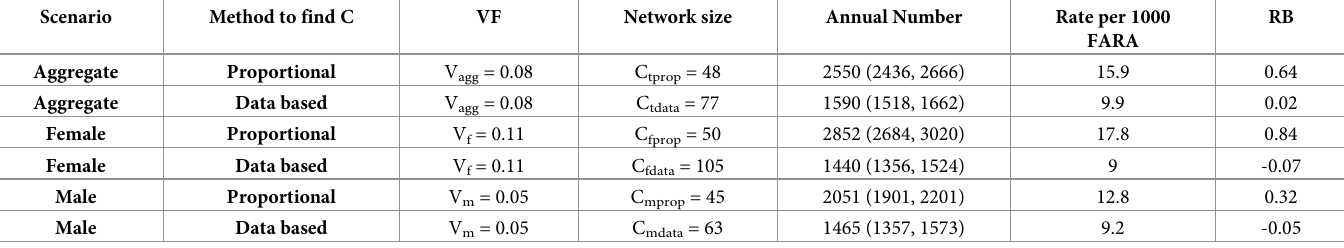
Table 2. Influence of the method of estimation of the network and the study population on the size estimation of the annual number of intentional abortions.